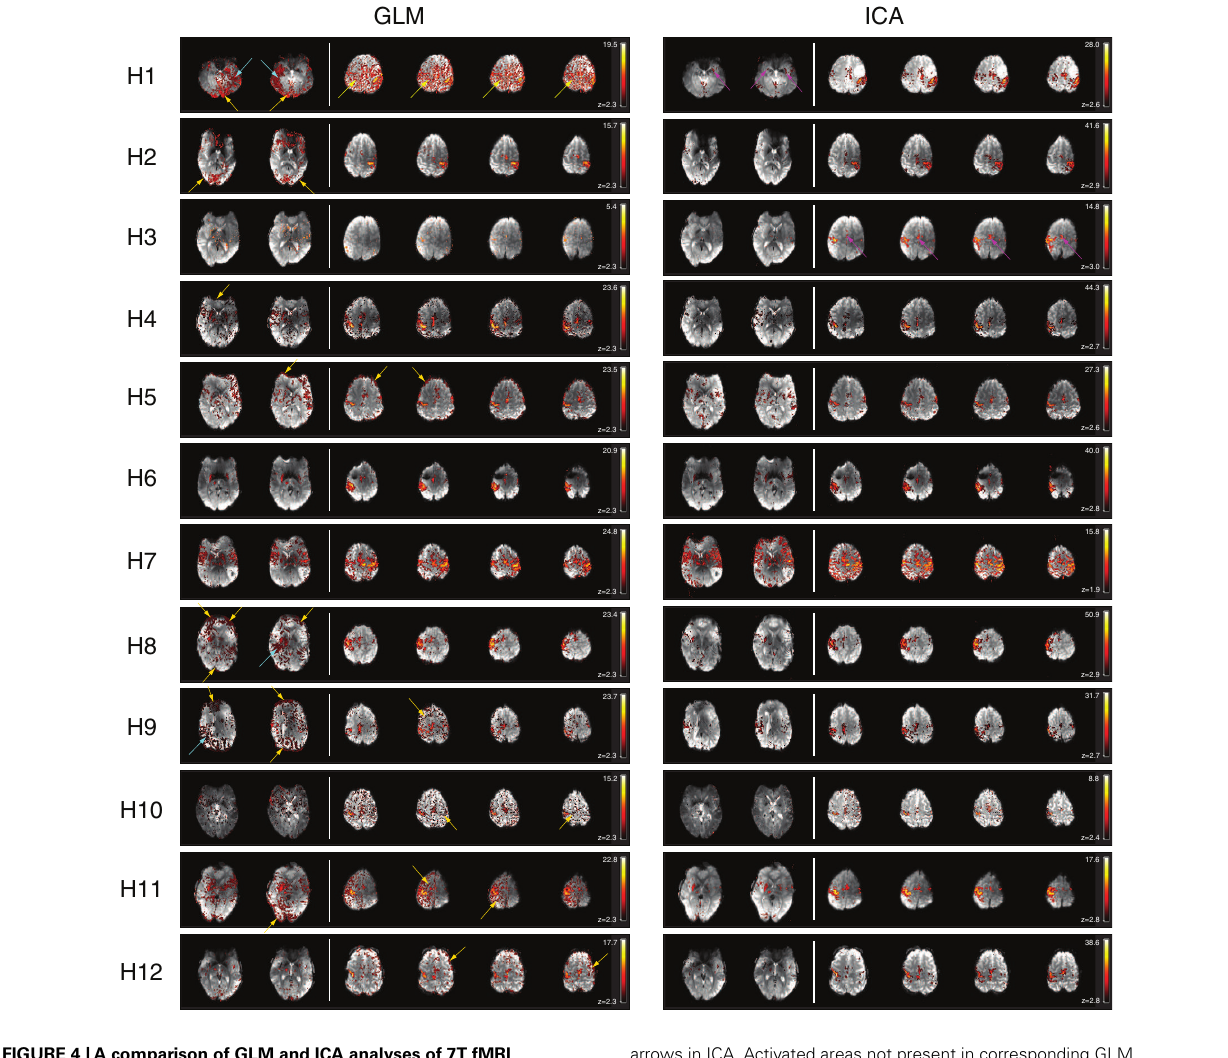
FIGURE 4 |A comparison of GLM and ICA analyses of 7T fMRI data with a hand task .The same thresholds were applied as in Figure 2 . Activation in the basal ganglia and thalamus is indicated by